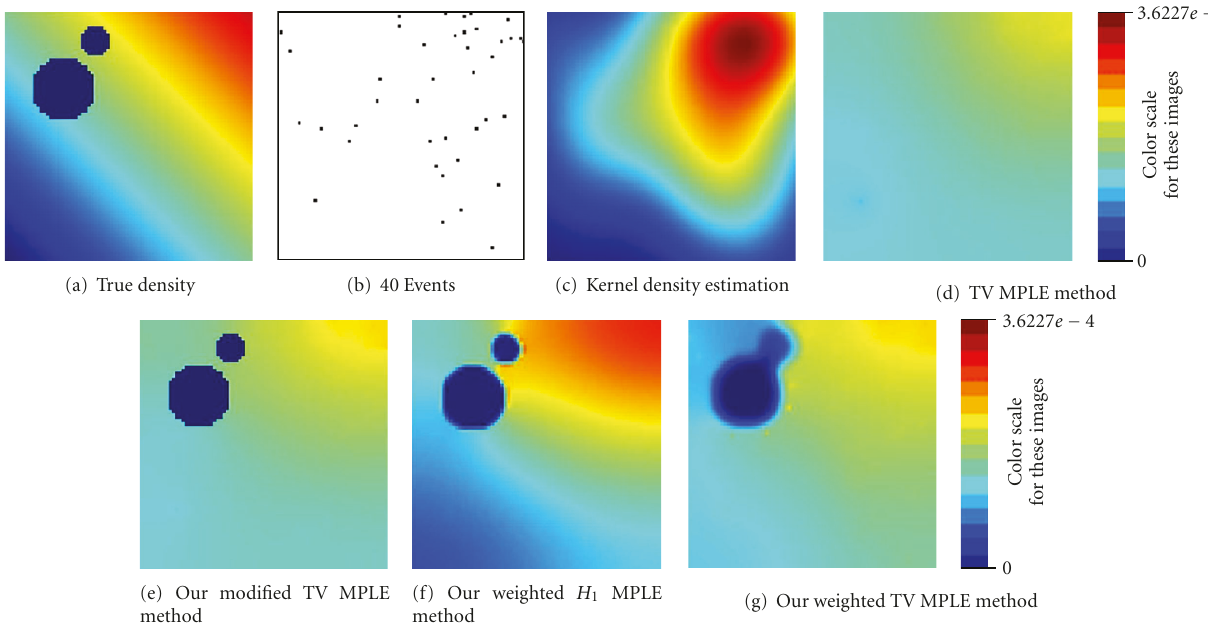
Figure 3: This is a sparse example with 40 events. The true density is given in (a), and it is the same density from the example in the introduction. The sampled events are shown in (b). (c) and (d) show the two current density estimation methods, Kernel Density Estimation and TV MPLE. (e), (f), and (g) show the density estimates from our methods. The color scale represents the relative probability of an event occurring in a given pixel. The images are 80 pixels by 80